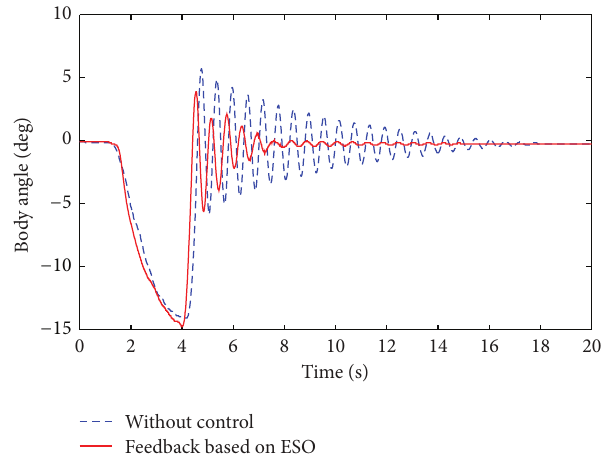
Figure 15: Experimental results of the body angle for releasing the beam after